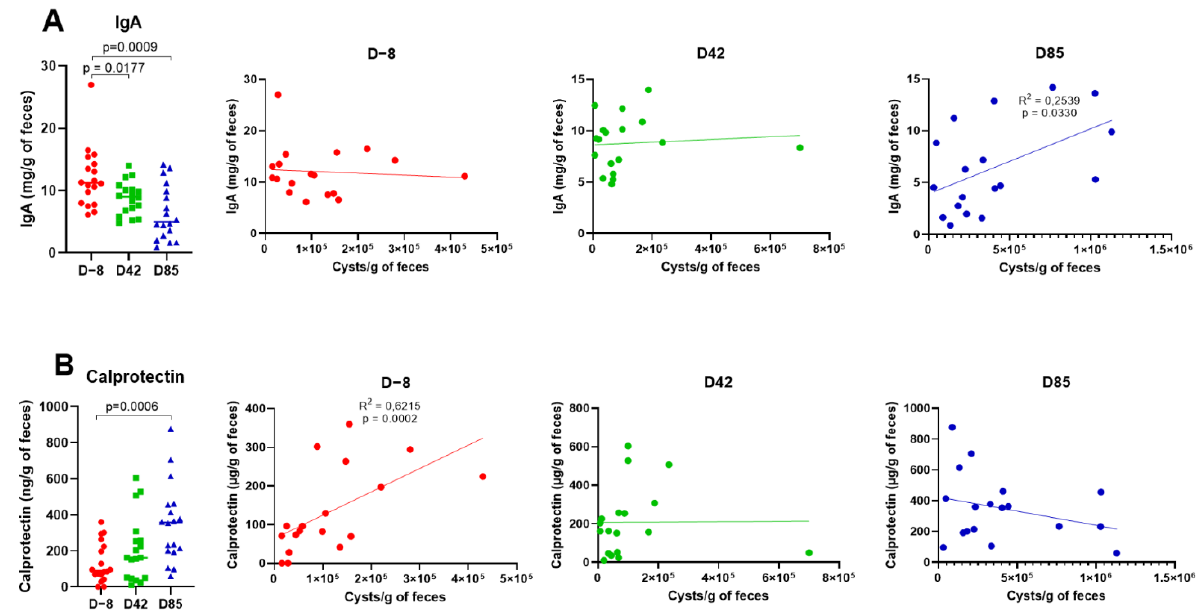
Figure 2. Fecal IgA ( A ) and calprotectin ( B ) concentrations and correlation with G. intestinalis cysts excretion in samples D−8 (red), D42 (green), and D85 (blue). Each dot represents a sample. p -values were determined using the Mann-Whitney test. Correlations were determined by Pearson’s coefficient.